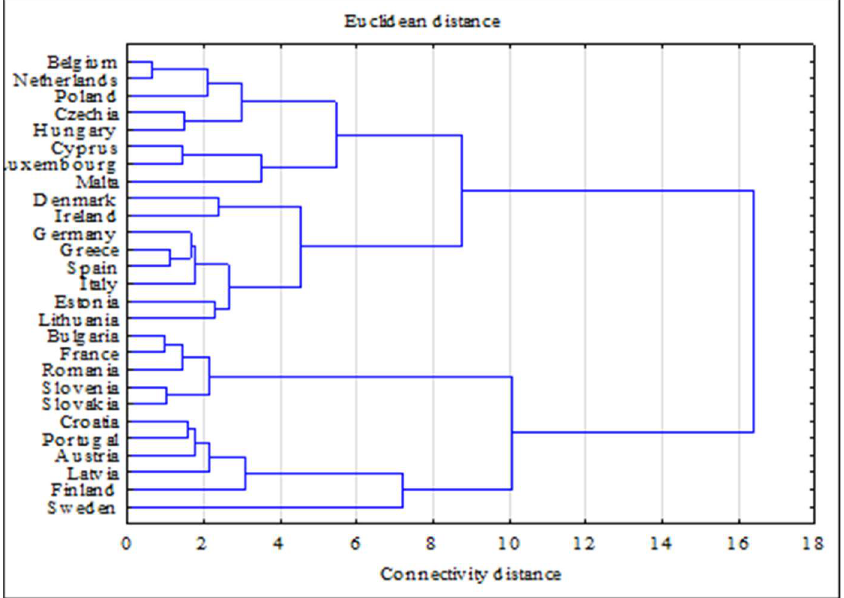
Figure 5. Similarity of EU countries in terms of the level of RES development in 2020 based on Ward’s method. Source: author’s own study.